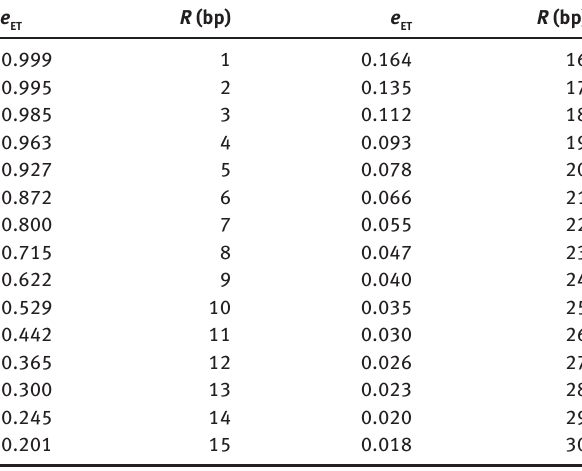
= (1- q / q ) from AO ET D oD